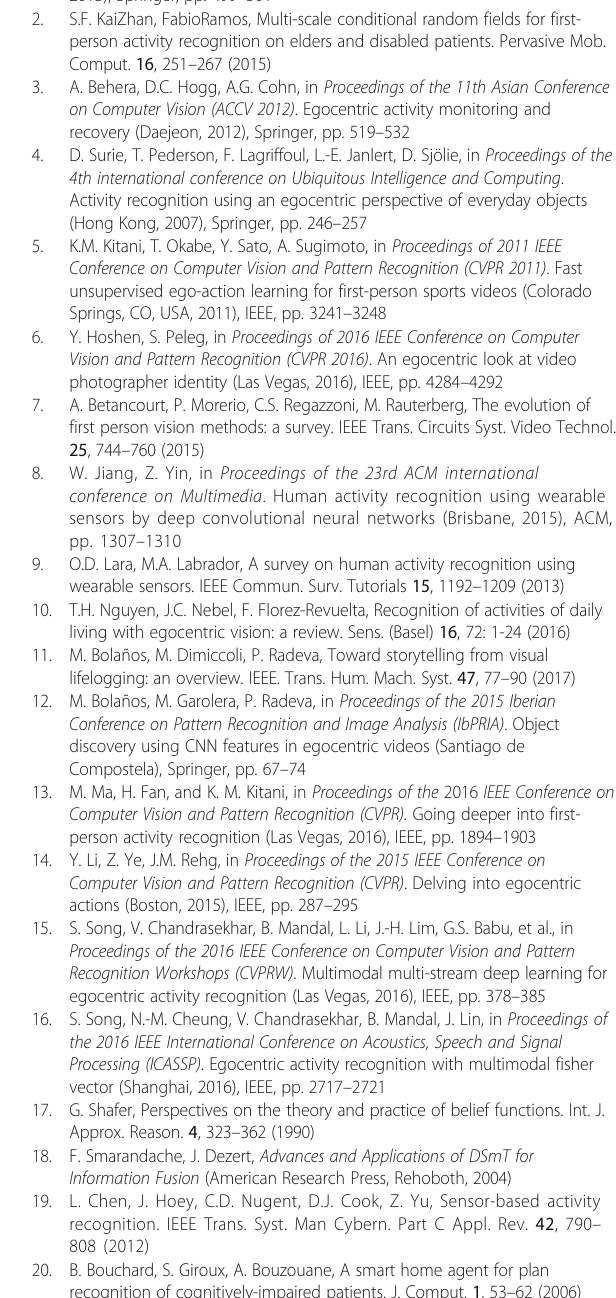
Abbreviations 2-L HFNDCS: Two-level hierarchical fusion network with descending